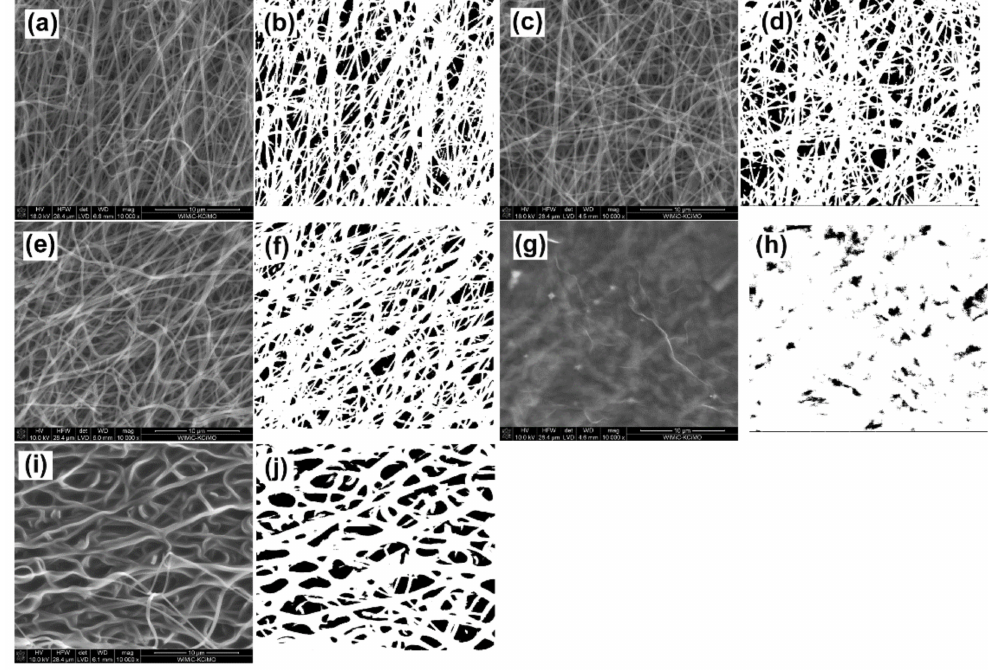
Figure 3. SEM images before and after thresholding for ( a , b ) CNFs; ( c , d ) CNF_ox, ( e , f ) CNF_NaH, ( g , h ) CNF_GO, and ( i , j )